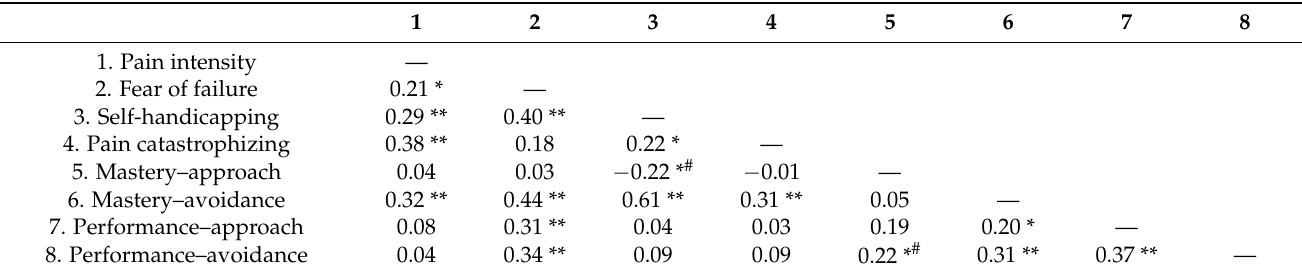
Table 3. Correlations between pain intensity, fear of failure, self-handicapping, pain catastrophizing and goal orientations.